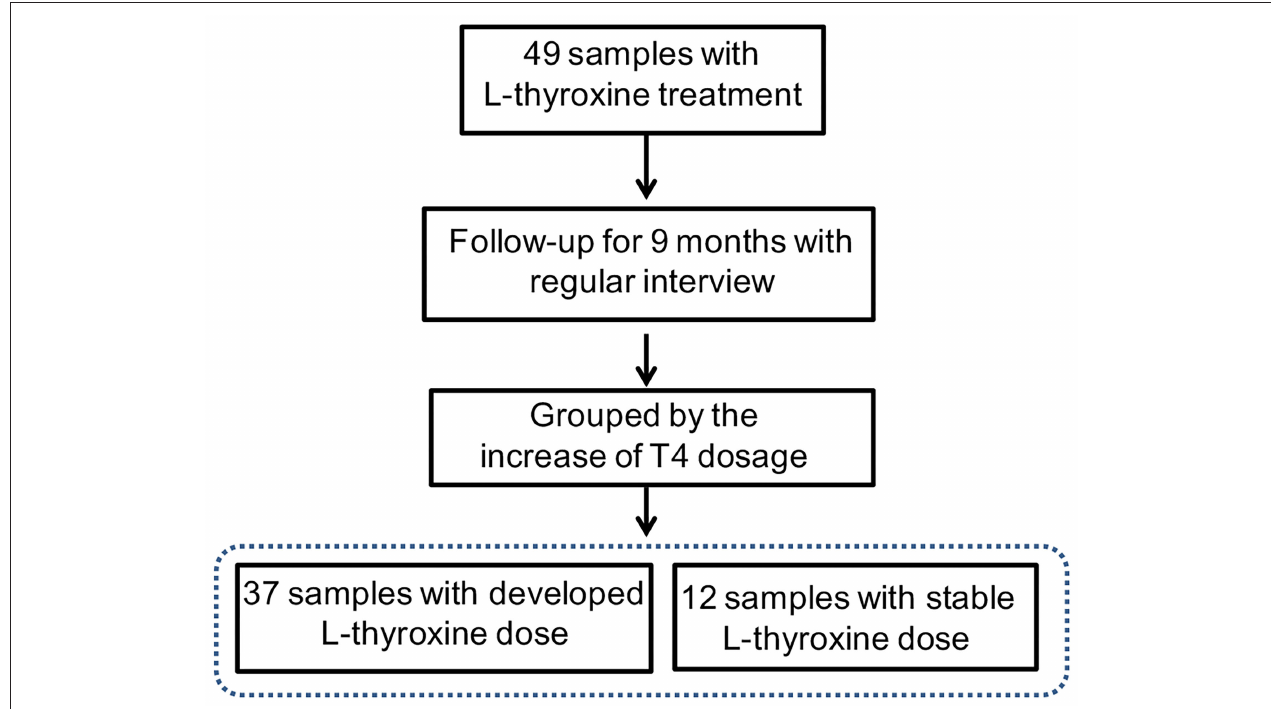
FIGURE 4 | Trial profile. Subjects in the L-thyroxine replacement therapy (LRT) group were manually subdivided into L-D (L-thyroxine dose increased) and L-ND groups (L-thyroxine did not increase) based on whether the dose had increased during the last 9 months or not.